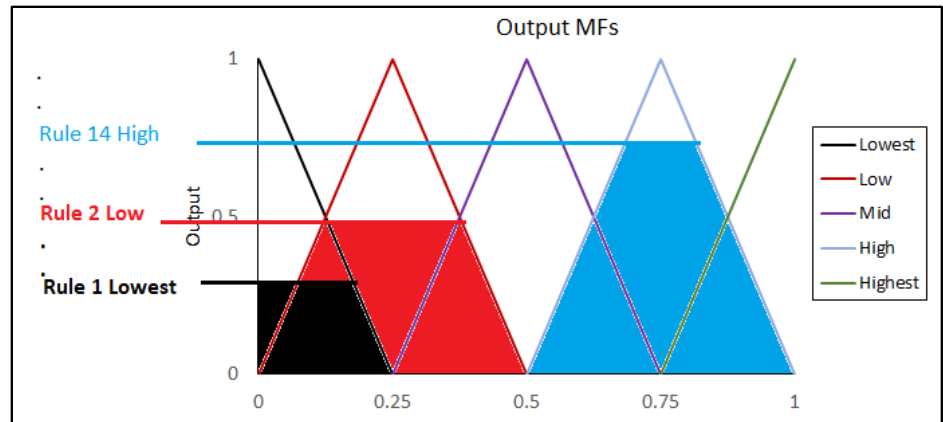
Figure 11. COG defuzzification